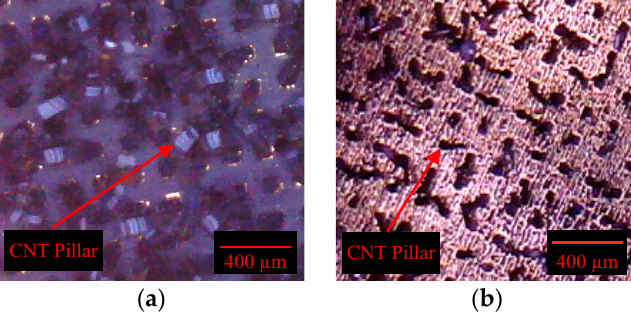
Figure 2. Images of pvCNT electrode without and with polypyrrole (PPy) coating. ( a ) Prior to PPy coating. ( b ) After PPy coating.